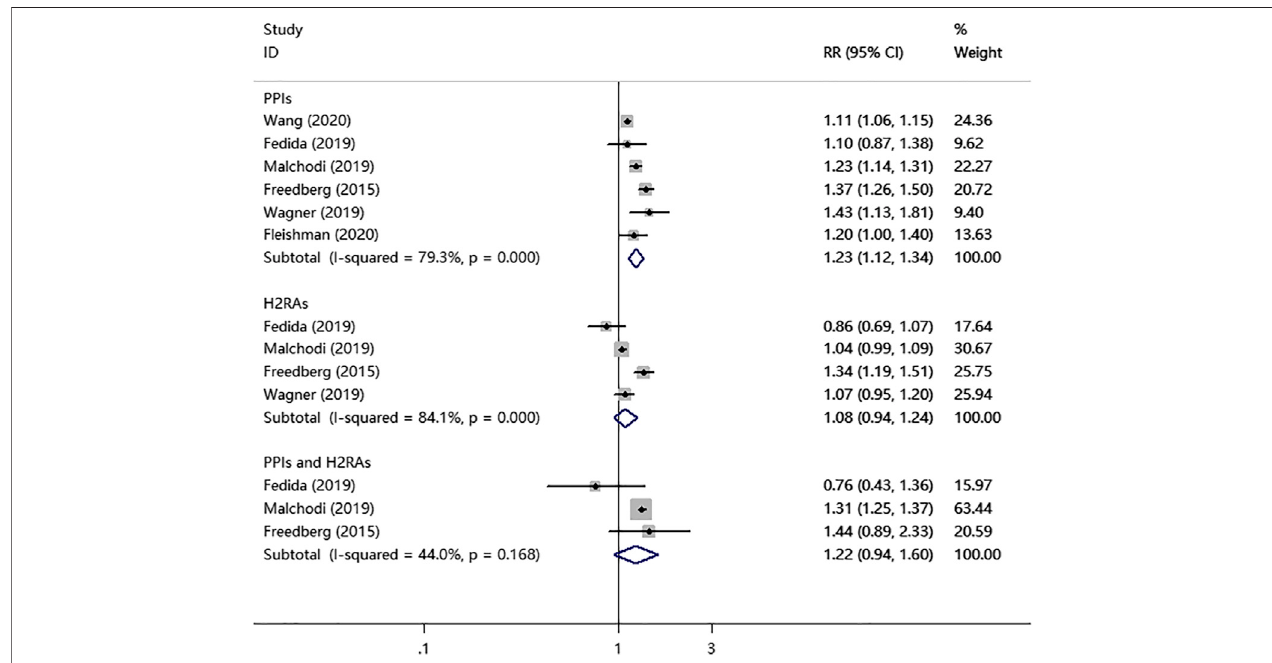
FIGURE 2 | PPIs, H2RAs, or PPIs combined with H2RAs use and the combined risk of fracture in a random-effects model meta-analysis.